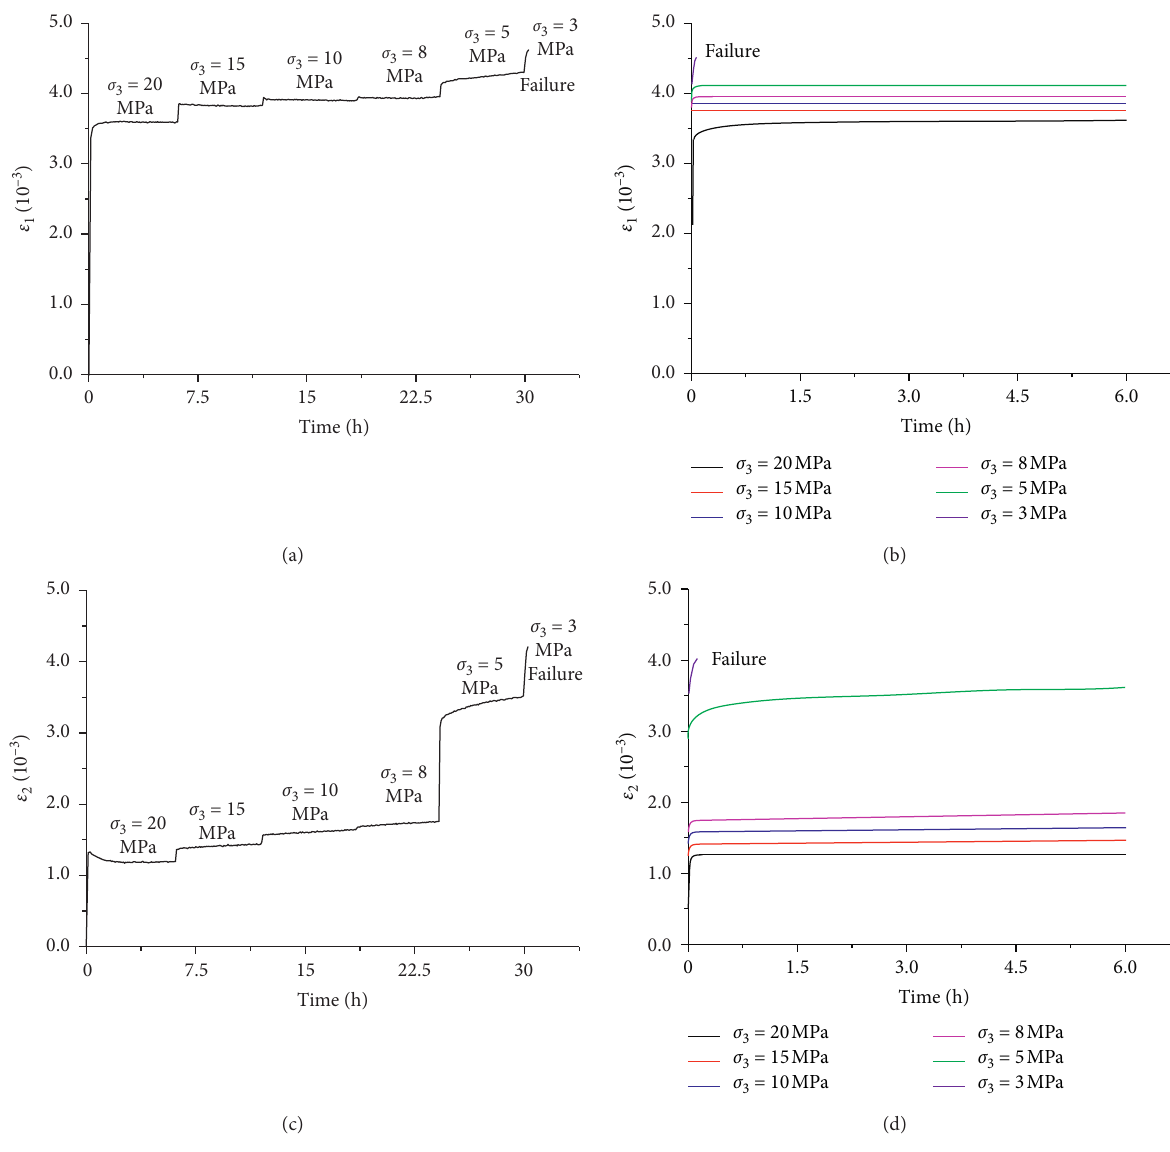
Figure 8: Unloading confining pressure with constant axial pressure triaxial test results of mudstone. (a) Change of axial strain with time. (b) Isochronous curves of axial strain. (c) Change of lateral strain with time. (d) Isochronous curves of lateral